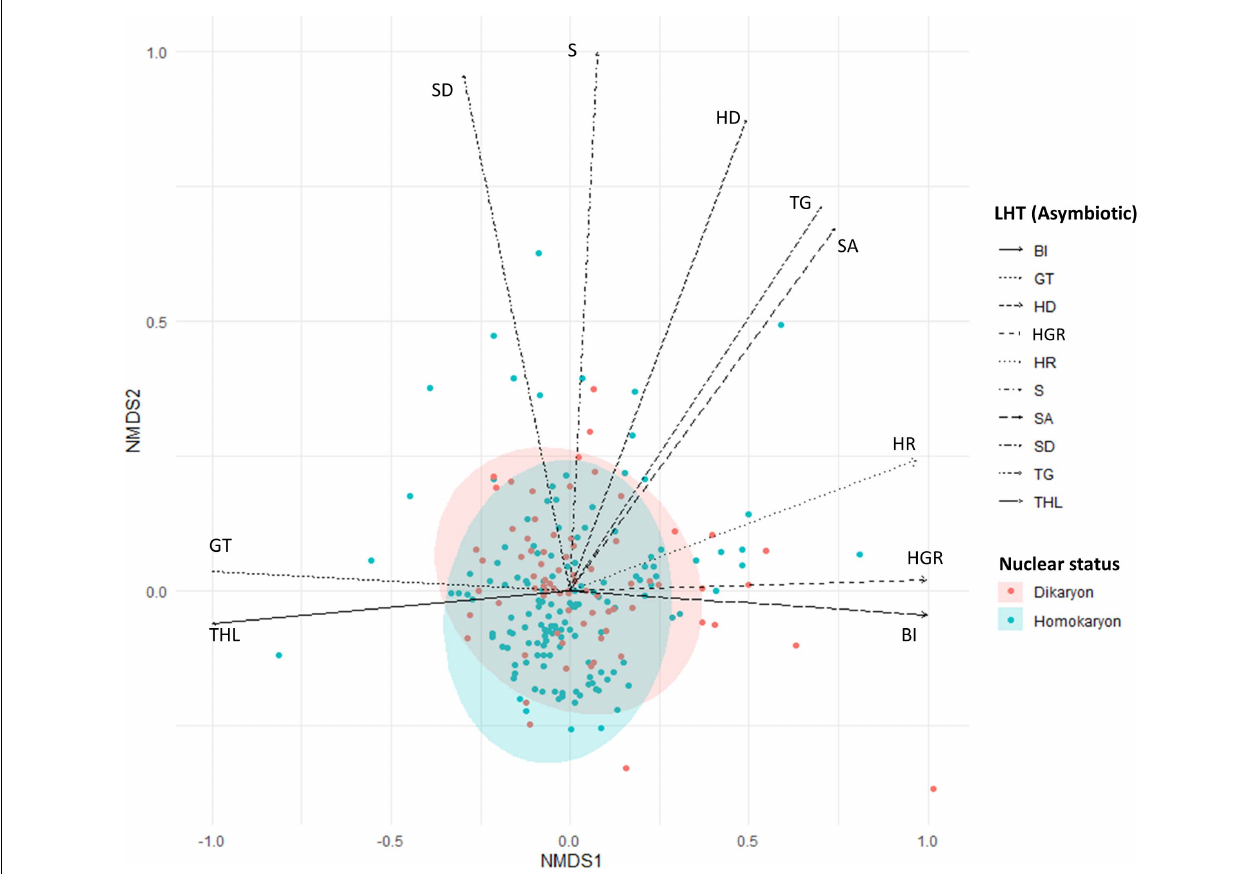
FIGURE 3 | Non-metric multidimensional scaling (NMDS) plot of homokaryotic (blue dots) and dikaryotic (red dots) strains based on the measured life history traits during the asymbiotic growth stage. Stress value = 0.1. The direction of the traits was obtained after fitting the measured traits in the ordination space. SD, spore diameter; SA, spore area; GT, number of germ tubes; HR, hyphal reach; HD, hyphal diameter; TG, time to germination; THL, total hyphal length; BI, branching intensity; S, septae per hyphal unit; HGR, hyphal growth rate. Blue and red ellipse are 95% CI.